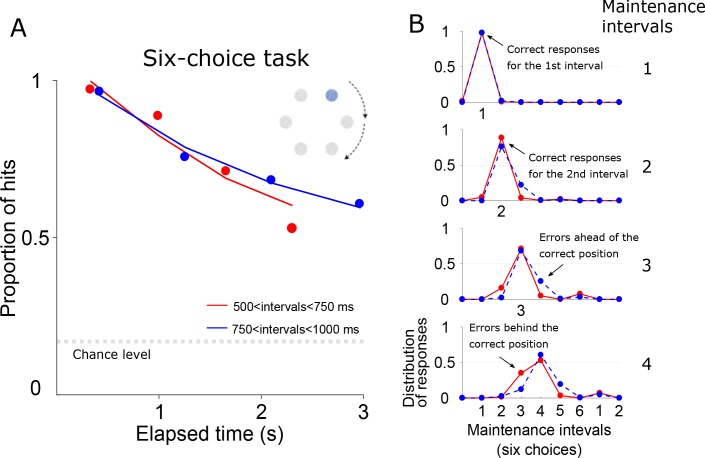
Six-choice version of the metronome task.(A) The probability of a correct response is plotted as a function of elapsed time for the maintenance intervals. In this version of the task, rhythm tempo was selected randomly from a uniform distribution of 500–1000 ms interval lengths. Trials were split into two groups comprising intervals below and above 750 ms (red and blue lines). Since there are six options for the behavioral response, chance level is at 1/6. (B) Each panel shows the distribution of behavioral responses associated with each maintenance interval. Note how there few errors associated with the first two maintenance intervals. For the 3rd and 4th maintenance intervals, the distribution of responses becomes wider and a pattern of error responses emerges: For the fast intervals (red lines), errors tend to lag behind the correct position. Conversely, for the slow tempos (blue line) errors tend to fall ahead of the correct position. Note how the pattern of errors is not random, but they tend to cluster around the correct response.